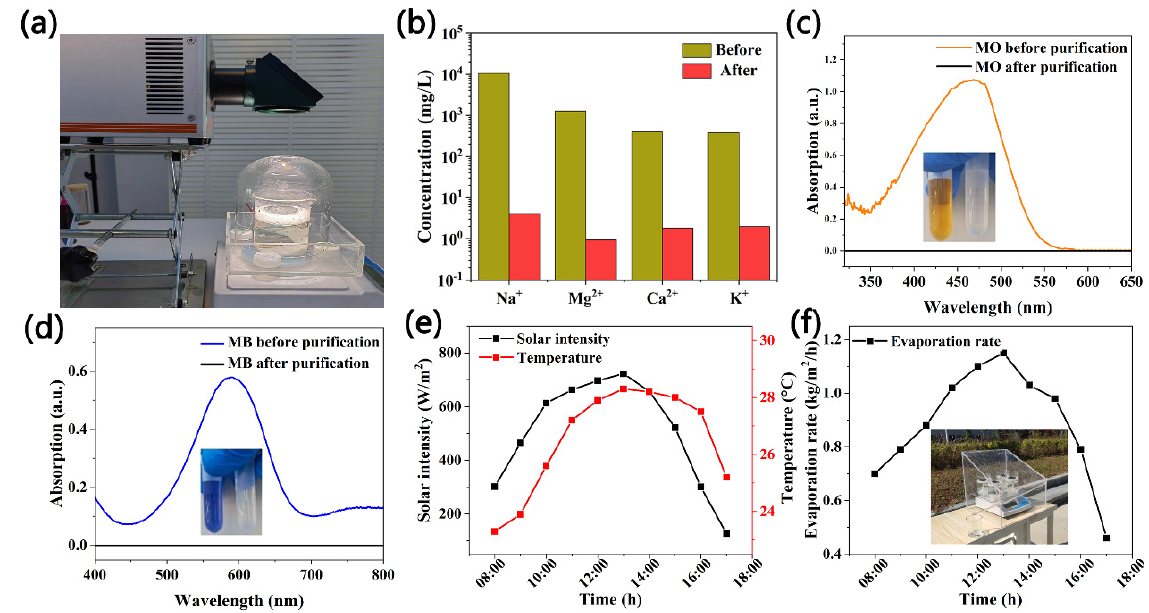
Figure 4. ( a ) Diagram of the freshwater collection device. ( b ) The concentration of Na + , Ca 2+ , K + , and Mg 2+ in seawater before and after desalination. ( c ) Absorption spectrum of MO before and after purification. ( d ) Absorption spectrum of MB before and after purification. ( e ) Solar intensity and ambient environment in outdoor experiments. ( f ) Evaporation rate and equipment in outdoor experiment.